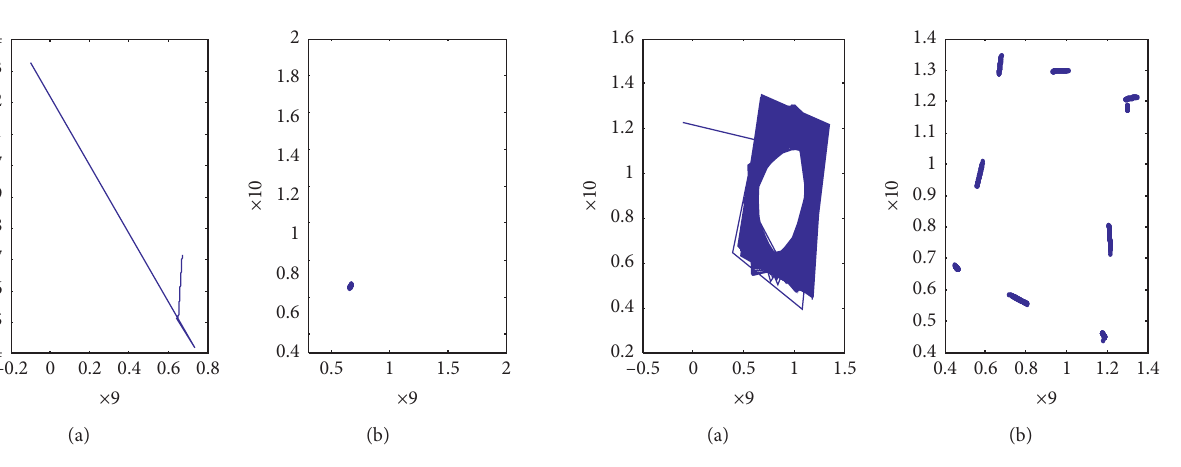
� 0 with the smoothed Coulomb model w